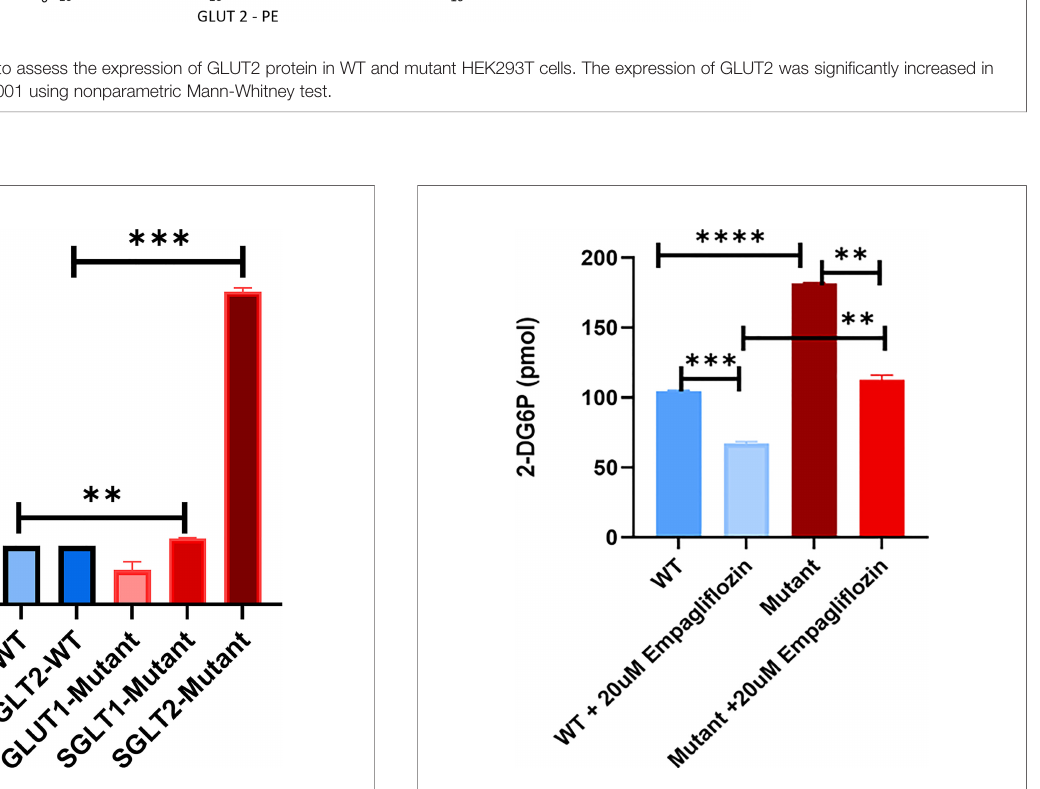
FIGURE 7 | Glucose uptake test in WT and mutant HEK293T cells using 2-DG. Mutant cells have signi fi cantly increased glucose accumulation in comparison to WT. Treatment of the cells with the SGLT2 inhibitor (Empagli fl ozin) con fi rmed the GLUT2 release activity in the mutant cells is disturbed. P-value was calculated using two-tailed t-test and presented with a ‘‘ * ’’ in the graph. **P values less than 0.01; ***P values less than 0.001; ****P values less than 0.0001.